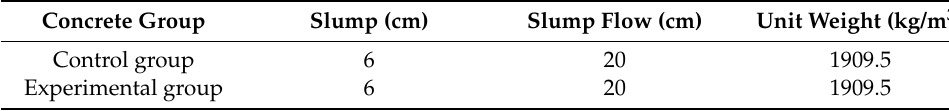
Table 6. Fresh properties of the concretes.